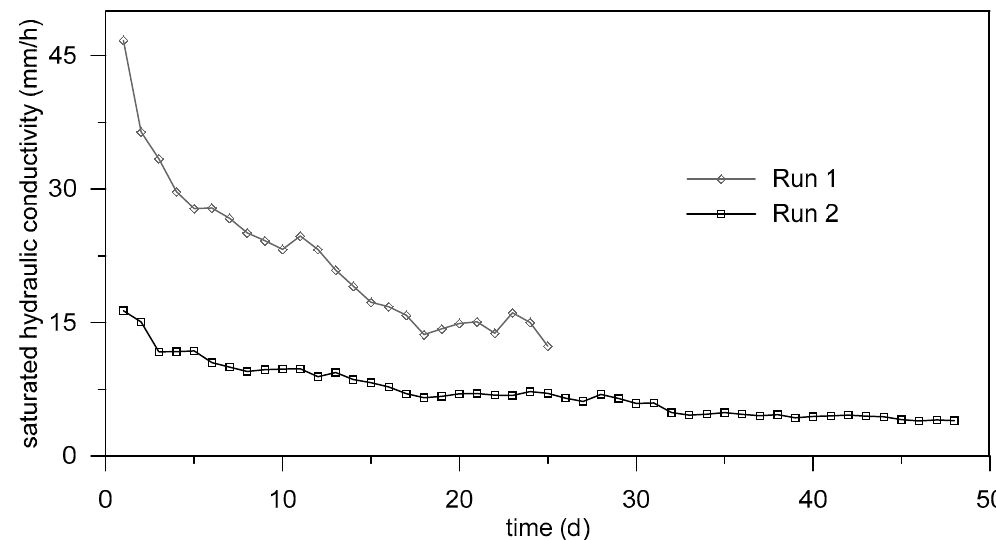
Figure 5. Results of the long-term clogging column experiments on Sandy Beach soil. A decrease of saturated hydraulic conductivity for the first run (Run 1) over 25 days and the second run (Run 2) over 48 days. Table 3. Characteristics of sediment trapped in gravel layer after Run 1 of the long-term flow clogging